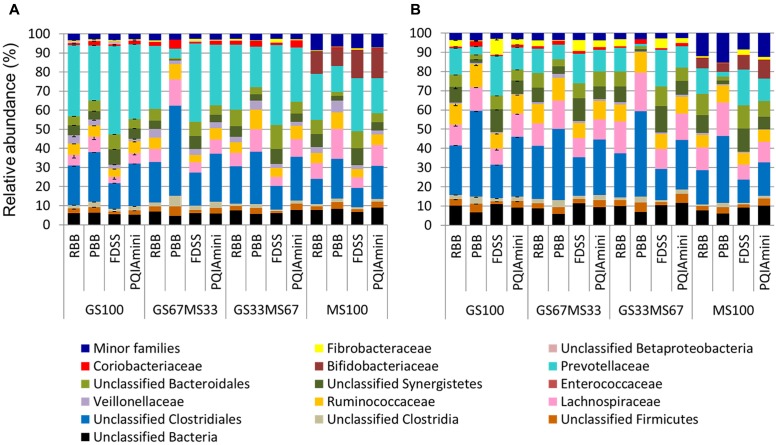
Bacterial family level composition of different DNA extracts obtained from rumen fluid (A) and fibrous content (B) samples from dairy cows each fed different ratios of grass silage (GS) to maize silage (MS), e.g., GS67MS33 is a diet containing 67% grass silage and 33% maize silage. All the stacked bars represent individual sample data except for GS100 which represents the mean of two different DNA extracts (error bars represent the standard deviation). All family level phylogenetic groupings > 1% are shown individually, with those <1% summed together and presented as minor families.